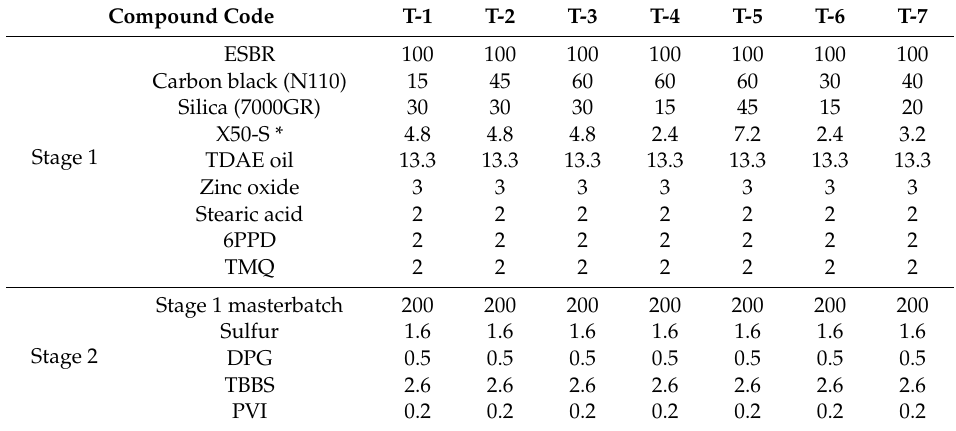
Table 1. Experimental formulations for compounds with carbon black and silica binary fillers given in parts per hundred rubber (phr).